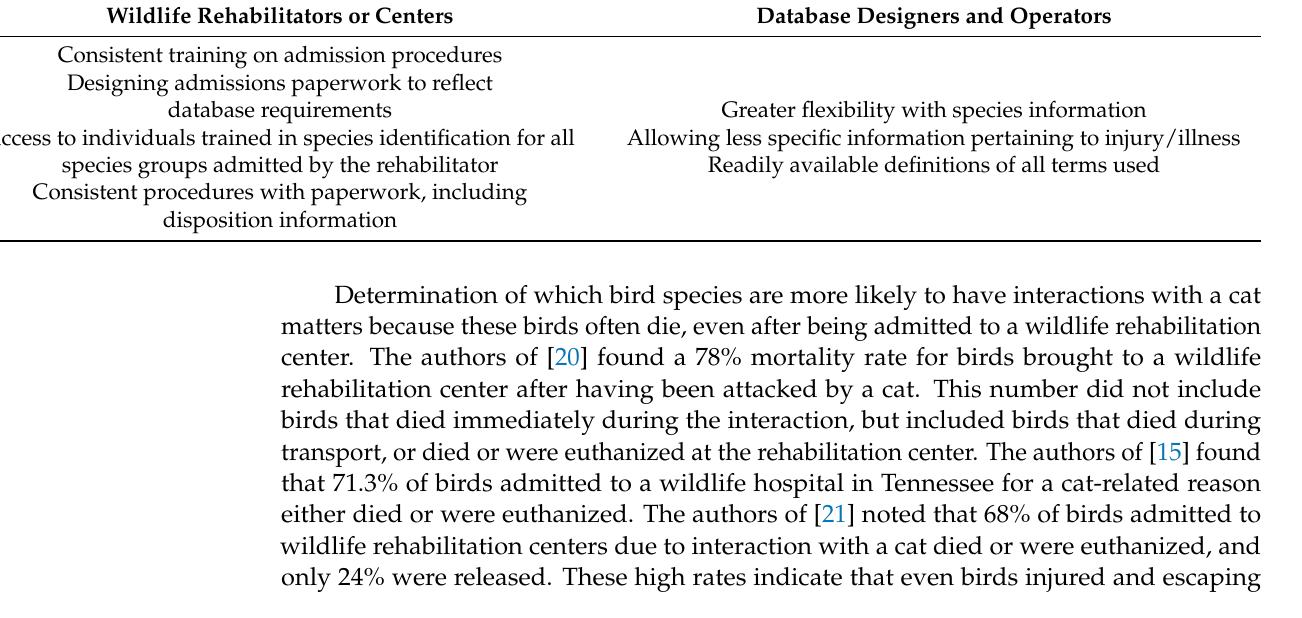
Table 6. Recommendations for wildlife rehabilitators and database designers to improve accuracy and scientific utility of data collected by wildlife rehabilitation